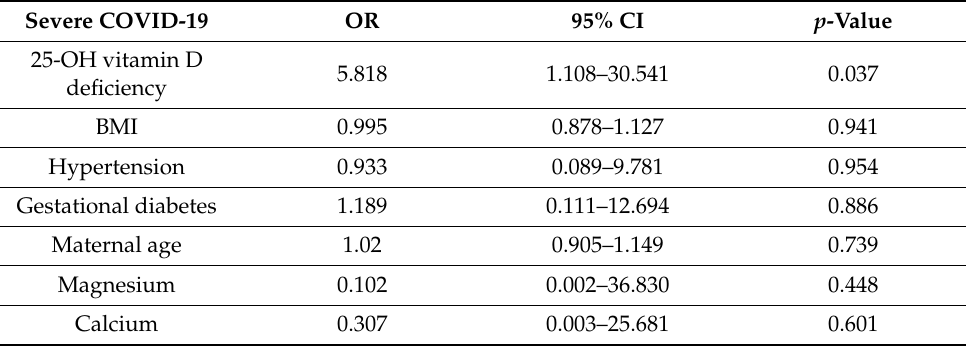
Table 3. Association between 25-OH vitamin D deficiency and severe COVID-19.